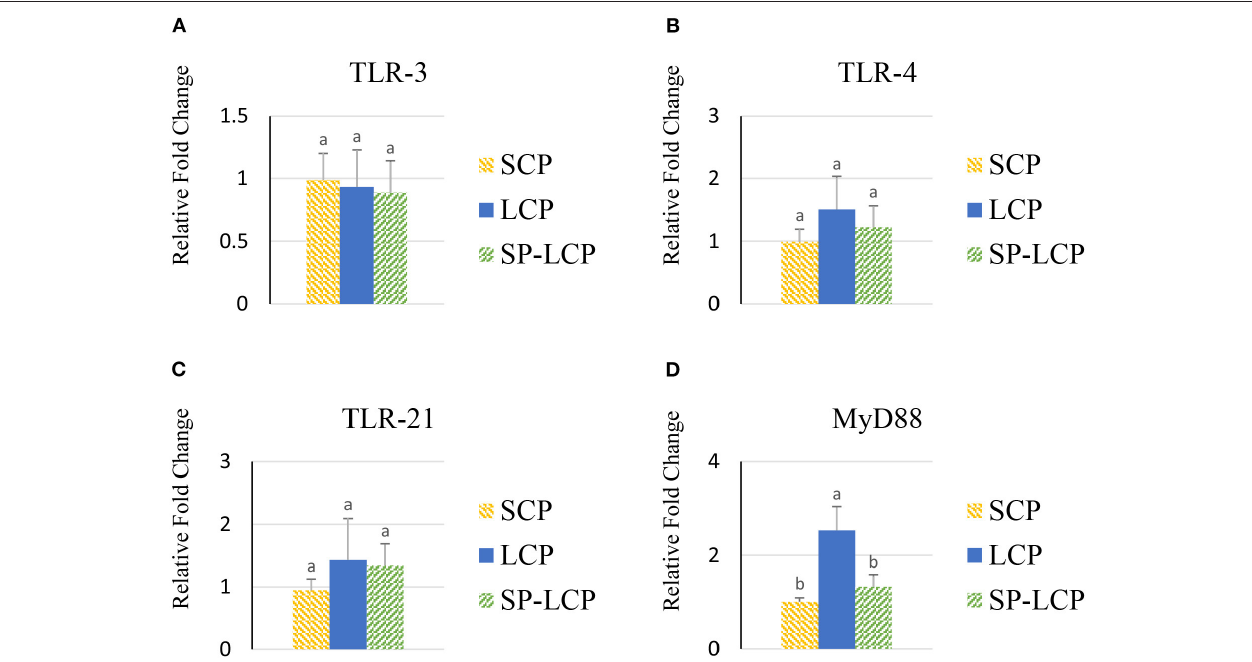
FIGURE 5 | Effects of Spirulina on circulating toll-like receptor expression. Relative mRNA abundance of toll-like receptor 3 (TLR-3) (A) , toll-like receptor 4 (TLR-4) (B) , toll-like receptor 21 (TLR-21) (C) , and myeloid differentiation primary response protein 88 (MyD88) (D) in the blood of broilers on day (d) 37 were determined by real-time qPCR. Treatments include standard corn/soy (SCP) diet as control and low crude protein without (LCP) or with Spirulina (SP-LCP). Data are presented as mean ± SEM ( n = 8/group). Means with different letters are significantly different ( P < 0.05).